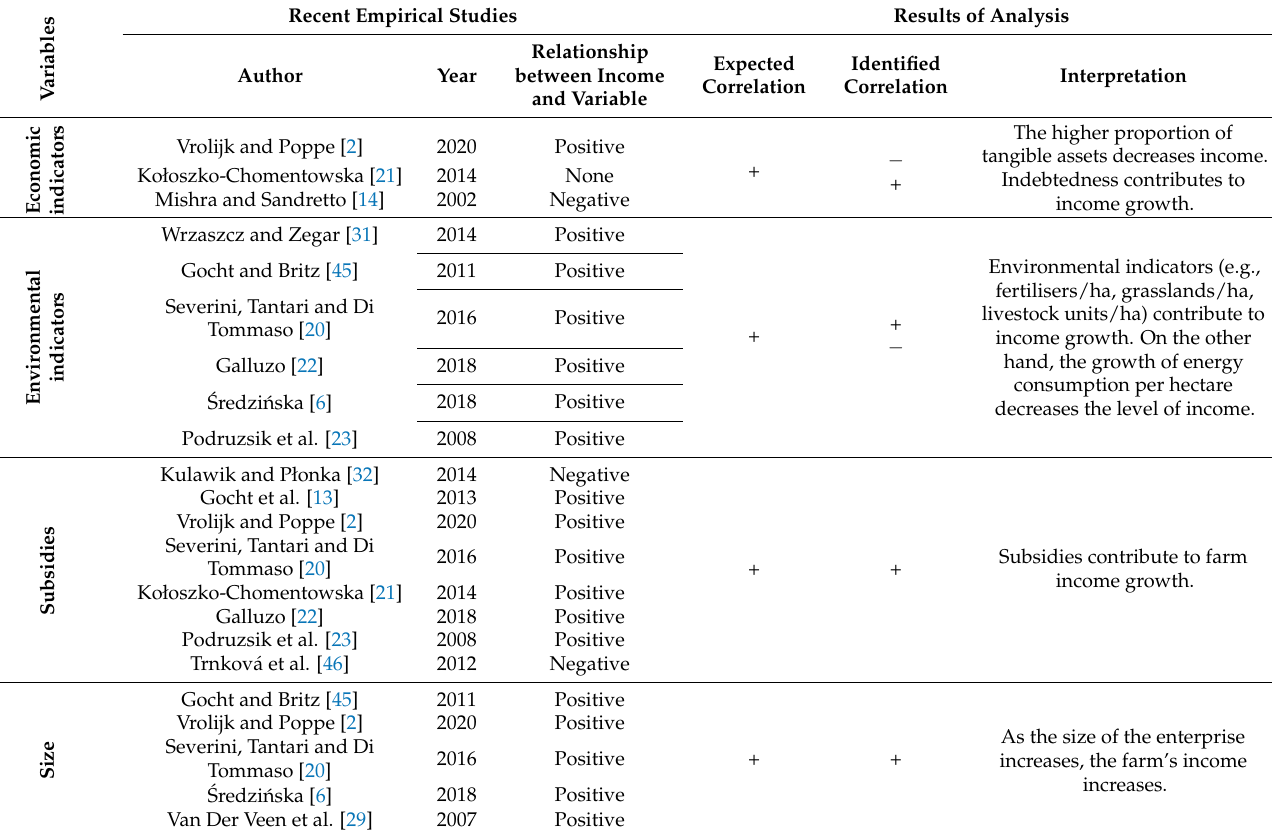
Table 6. The comparison of the selected empirical studies with our